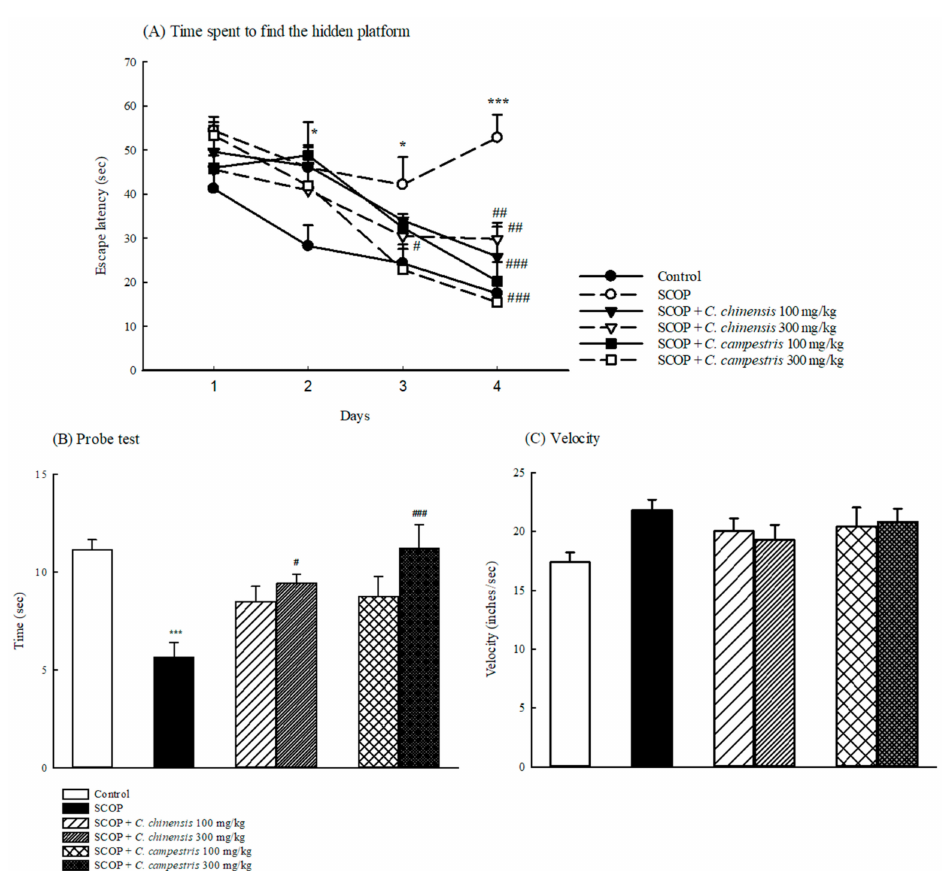
Figure 4. The effects of Cuscuta chinensis and C. campestris extracts (100 and 300 mg/kg, po) on ( A ) swimming time on Days 1–4 of MWM, ( B ) probe test of MWM, and (C) swimming velocity in scopolamine (SCOP, 1 mg/kg, ip)-injected mice. Columns indicate mean ± SEM ( n = 7). * p < 0.05, *** p < 0.001 compared with the control group. # p < 0.05, ## p < 0.01, ### p < 0.001 compared with the SCOP